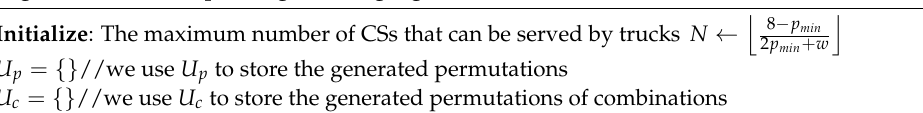
Algorithm 1. CSs sequence generating